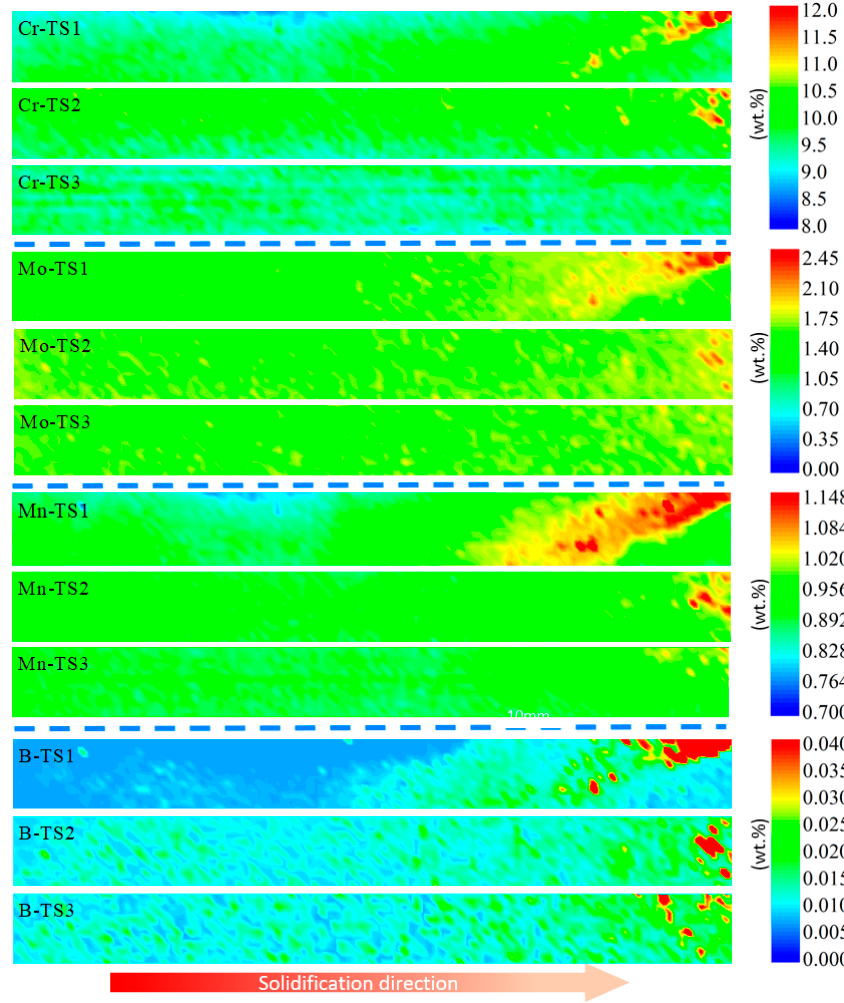
Figure 10. Content distribution of Cr, Mo, Mn, and B solutes in three TS samples.